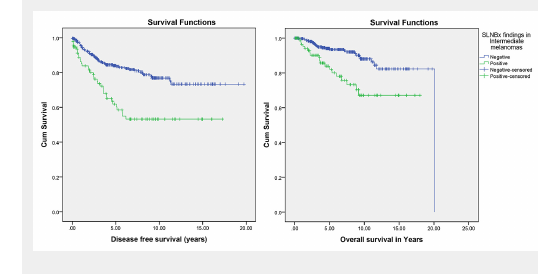
Effect of sentinel lymph node biopsy (SLNBx) result on disease-free and overall survival in thin melanoma (p <0.001 and p = 0.077, respectively).